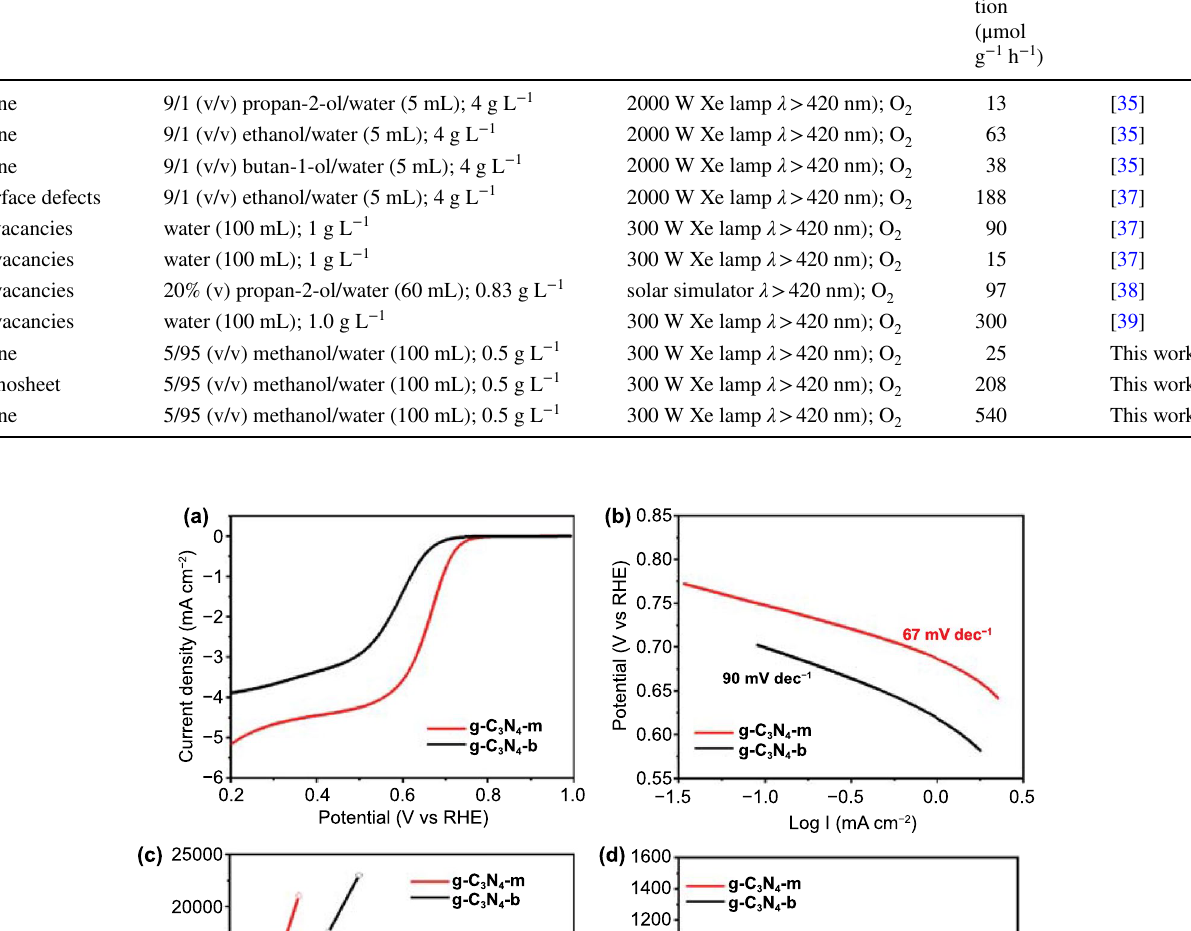
Table 1 Comparison of the photocatalytic H 2 O 2 generation of g‑C 3 N 4 g‑C 3 N 4